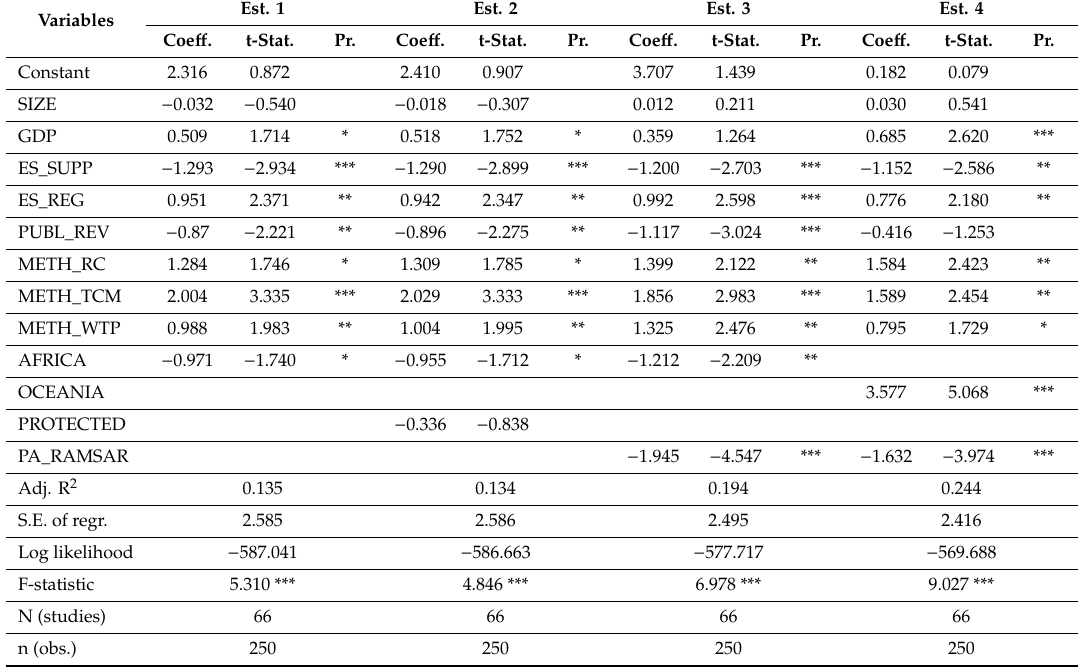
Table5. Econometricestimationsofthedeterminantsofthevaluesofecosystemservices(benefit-transfer